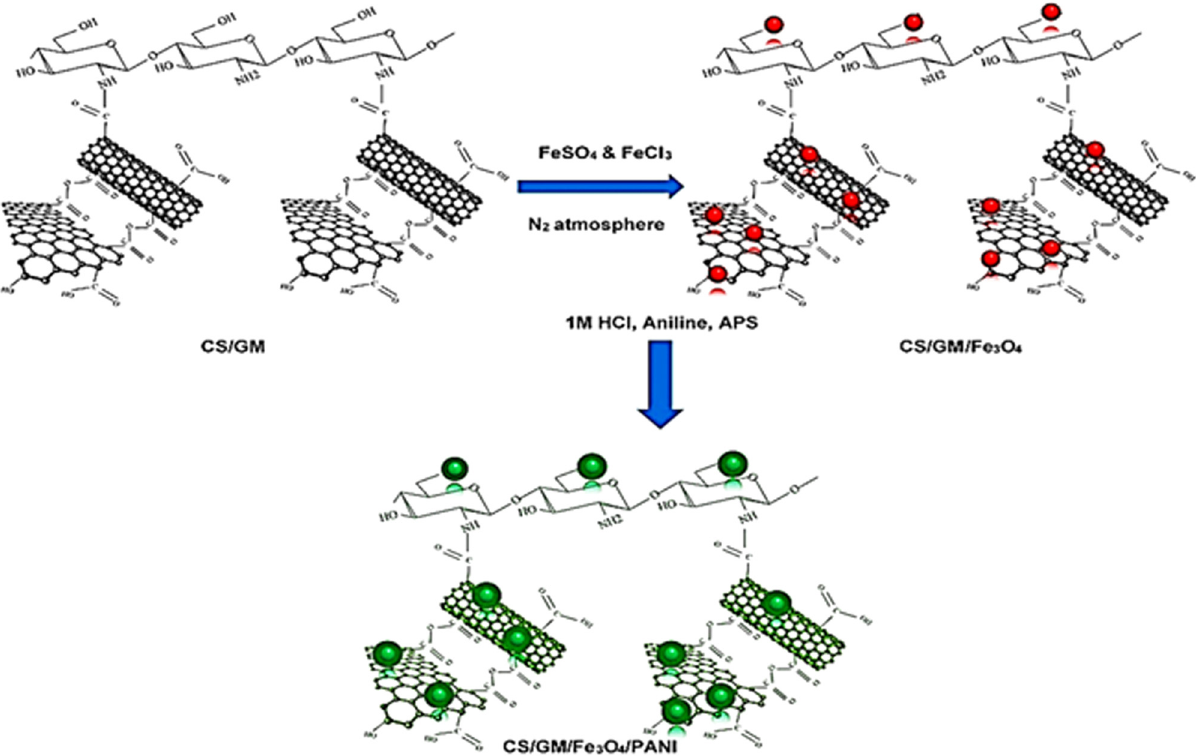
Figure 11: Simpli fi ed schematics of the synthesis of CS/GM/Fe 3 O 4 /PANi nanocomposite material. Reproduced from ref. [ 147 ] , Copyright 2021, John Wiley &